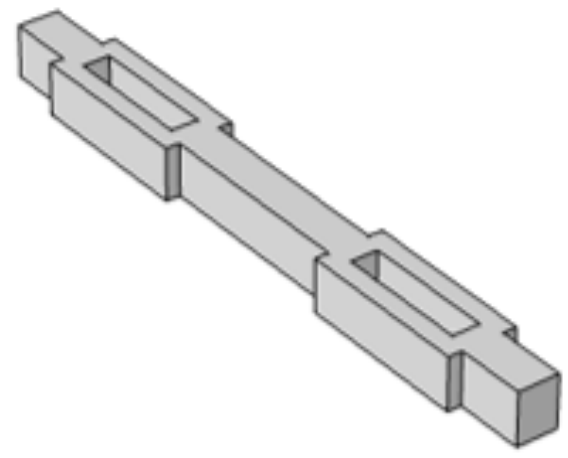
Figure 8. Design of hollow beams.